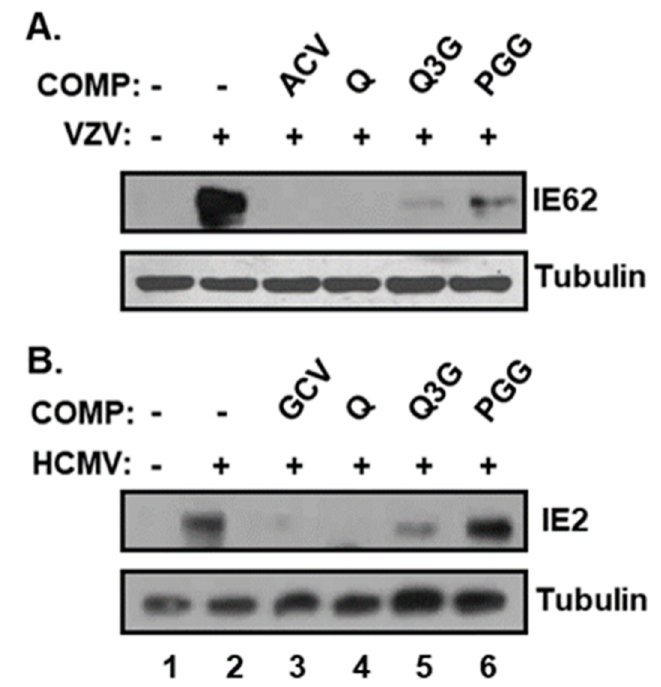
Figure 6. Effects of quercetin and isoquercitrin on VZV and HCMV IE protein levels. HFF cells were ( A ) inoculated with VZV–pOka-infected HFF cells or ( B ) infected with HCMV–Towne at an MOI of 0.1, followed by treatment with DMSO, quercetin (Q), and isoquercitrin (Q3G) or 1,2,3,4,6-penta-O-galloyl-ß-D-glucose (PGG) at a concentration of 20 µg/mL. As a control, VZV- and HCMV-infected HFF cells were treated with ACV (1.2 µg/mL) and GCV (2.3 µg/mL), respectively. At 48 h after infection, equal amounts of cell lysates were subjected to Western blot with antibodies against VZV IE62, HCMV IE2, and tubulin. COMP, compound.